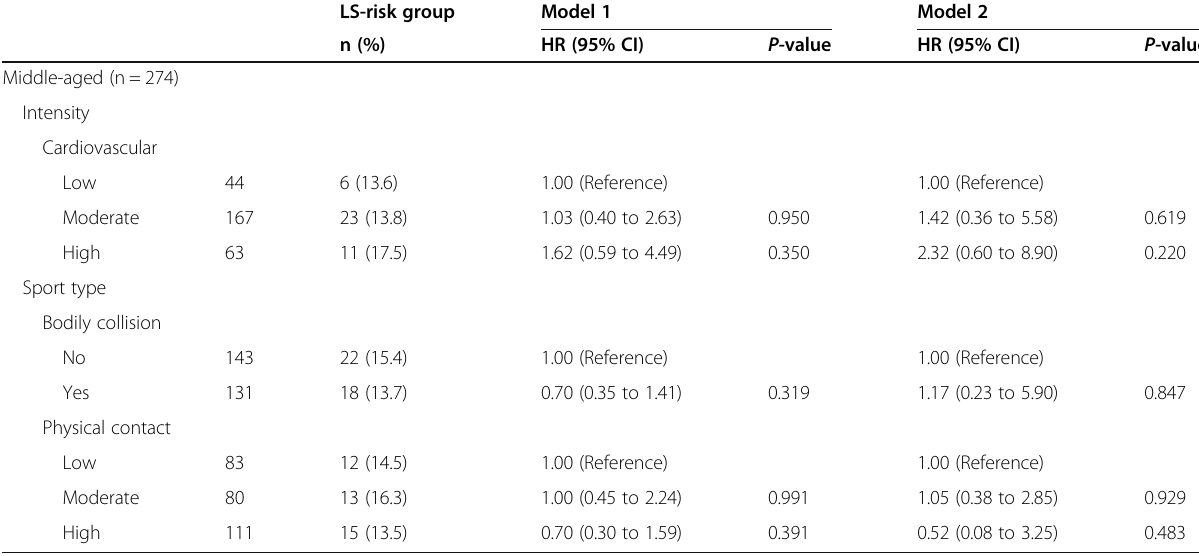
Table 4 Hazard ratios associated with locomotive syndrome according to different intensity of exercise and risk of bodily collision and physical contact based on middle-aged